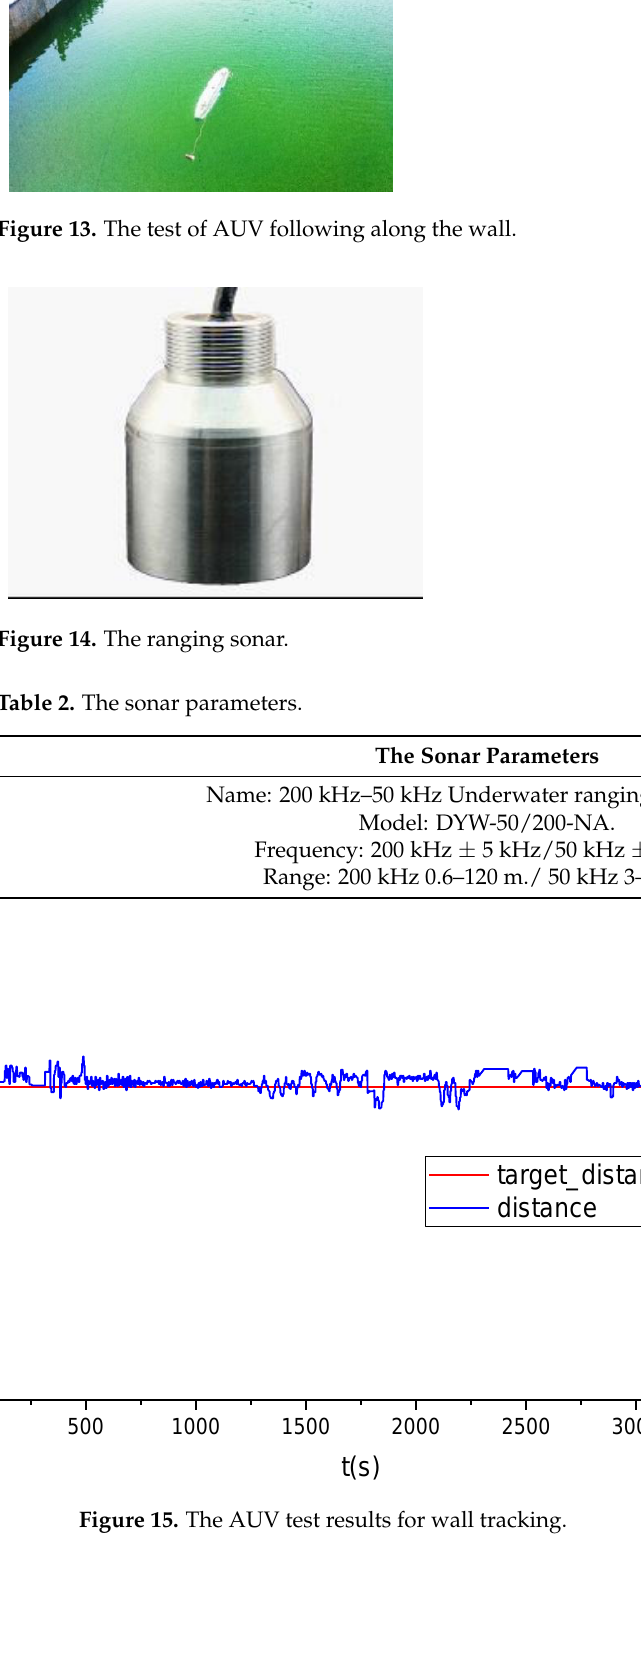
Figure 15. The AUV test results for wall tracking.